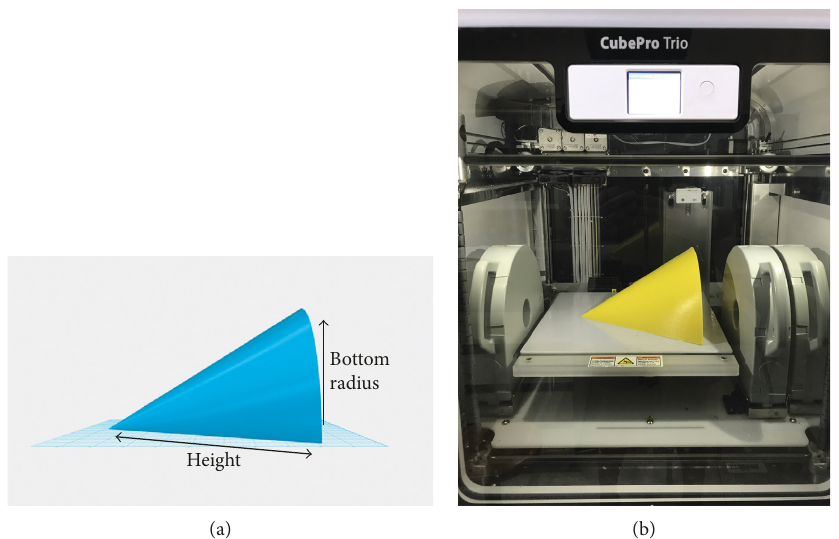
Figure 2: Half-cone-shaped curvature measurement jig preparation (cone height: 198 mm; bottom radius: 124 mm). (a) Half-cone design using Autodesk 123D. (b) 3D printed jig.